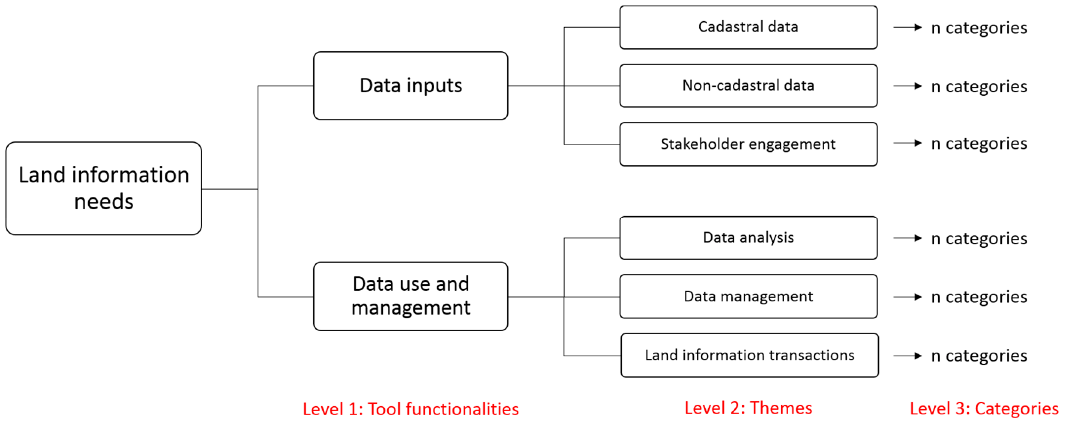
Figure 1. Three-level coding framework for land information needs.